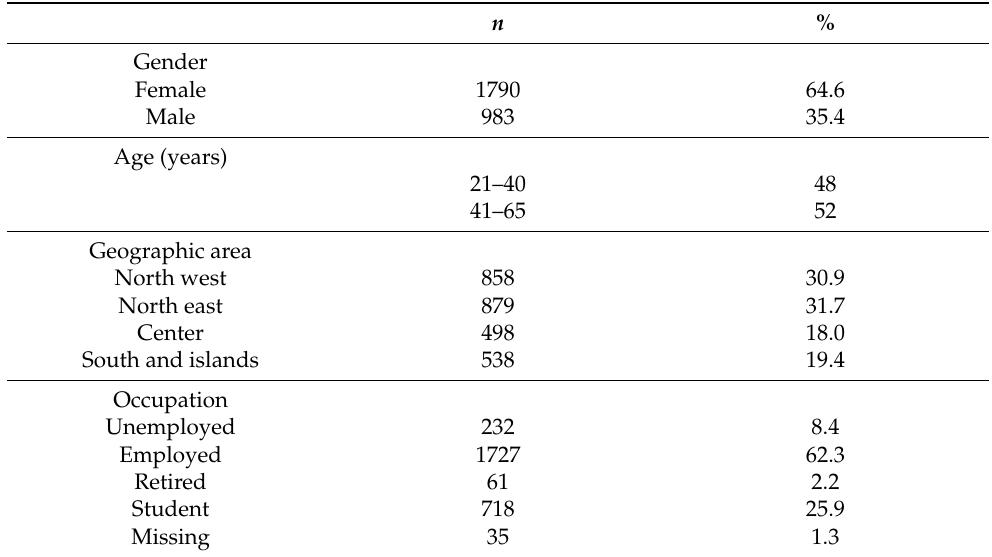
Table 1. General characteristics of the study participants ( n =